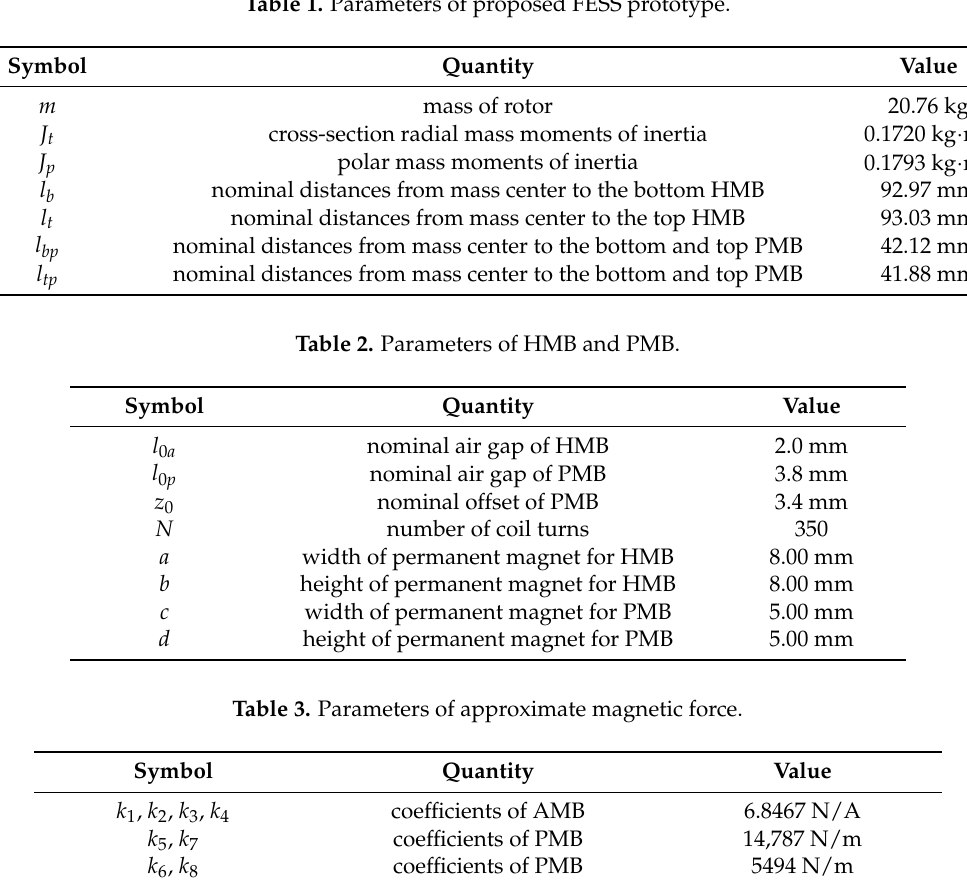
Table 1. Parameters of proposed FESS prototype.